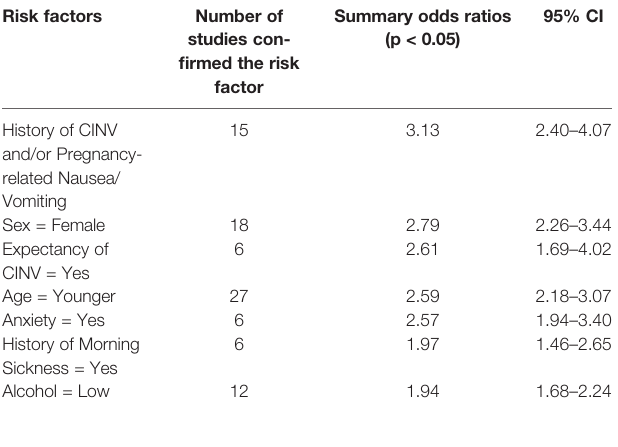
TABLE 3 | Important risk factors of Chemotherapy-Induced Nausea and Vomiting